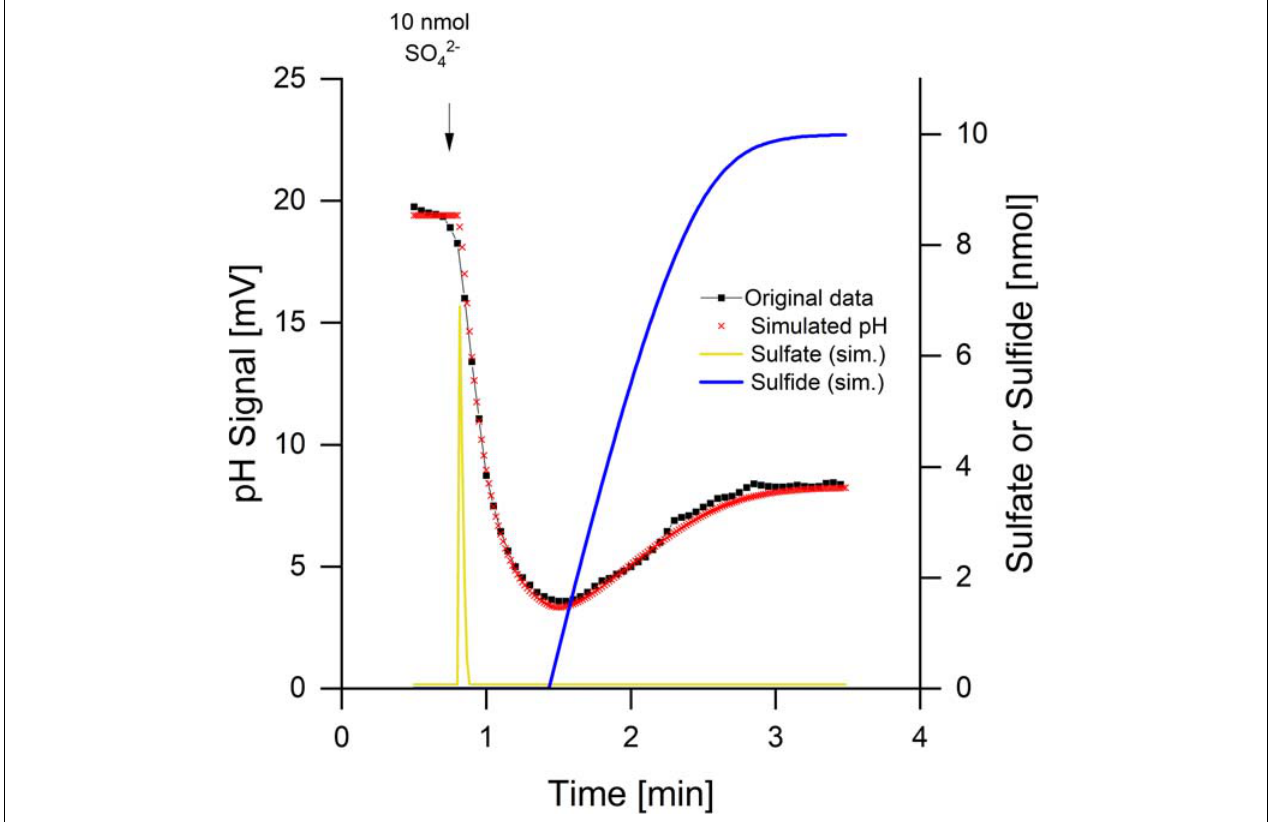
FIGURE 3 | Sulfate reduction by Desulfovibrio desulfuricans CSN grown under sulfate limitation. Conditions as described in Figure 1 , data from Cypionka (1995). Additionally to the pH curve, sulfate uptake and sulfide release were simulated by means of proton.exe (parameters see Supplementary Material , standard deviations see Supplementary Table 1 ). The simulation includes initial proton-sulfate symport followed by sulfate reduction and release of H 2 S part of which dissociating to H + + HS −